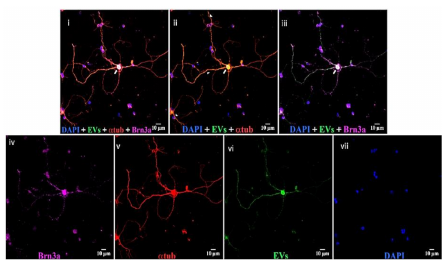
Figure 9. EVs in mixed retinal neurons. Top panels, left to right, ( i ) DAPI (blue), EVs (green), anti- α - tubulin (red), and anti-Brn3a (magenta); ( ii ) DAPI, EVs, and anti- α -tubulin; and ( iii ) DAPI, EVs, and anti-Brn3a. Bottom, ( iv ) anti-Brn3a, ( v ) anti- α -tubulin, ( vi ) EVs, and ( vii ) DAPI. Arrows = overlap (yellow) of α -tubulin and EVs in cytoplasm of RGCs, and arrowheads = yellow overlap in nerve projections from RGCs. White in RGC nucleus in panel iii is overlap of Brn3a magenta and green EVs. Scale bars (10 µ m) are on the bottom right of each panel 63x.